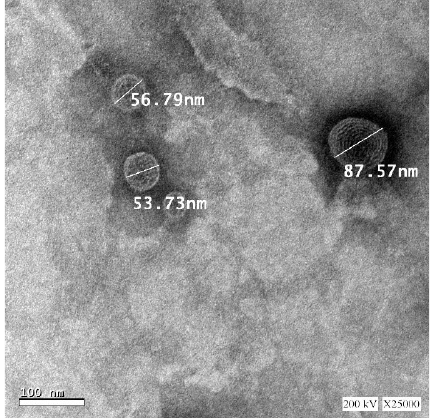
Figure 5. Transmission electron microscope (TEM) of optimized FLB niosomes, 25,000× magnification.